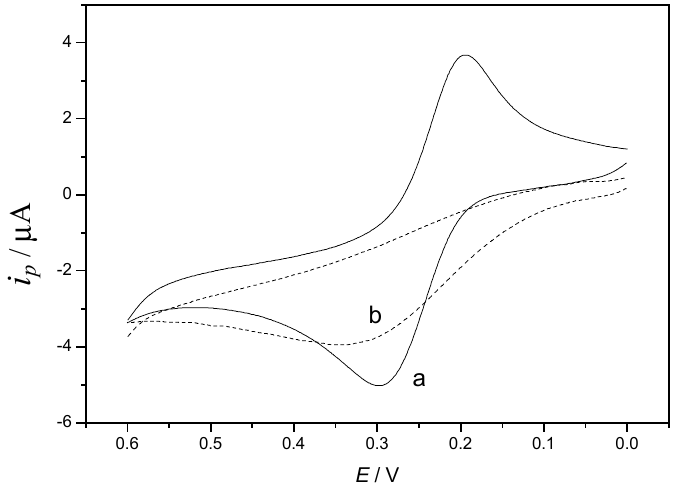
Figure 4. Cyclic voltammograms of 1.0 mM NE (a) and 1 mM AA (b) on ME/Au SAMs in B-R buffer (pH 5.5) at a scan rate of 50 mV s -1